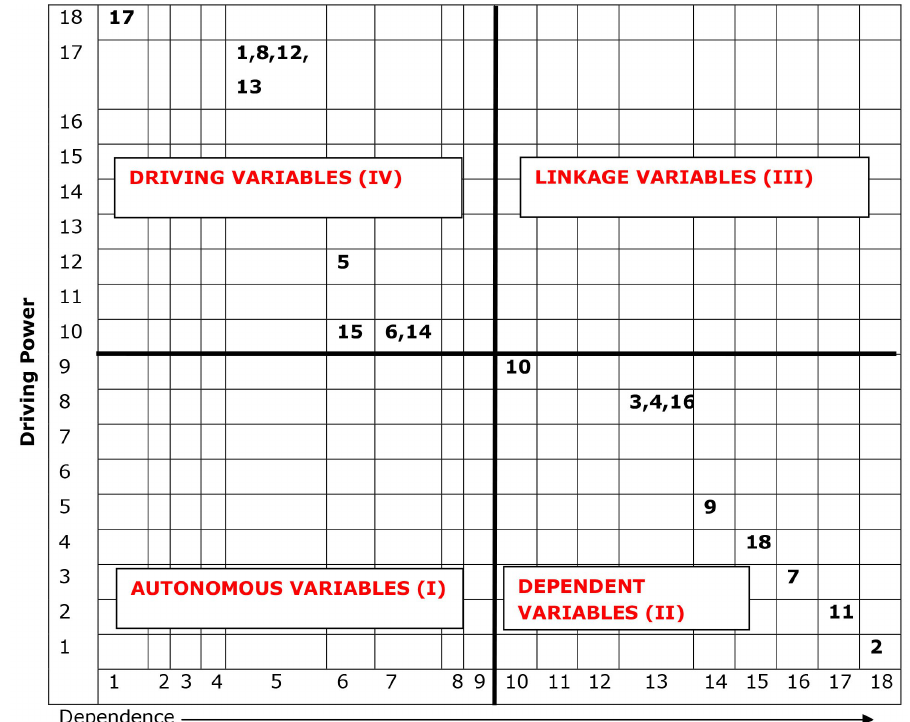
Figure 4. Clusters of Variables of Lean Manufacturing System in Indian Automobile